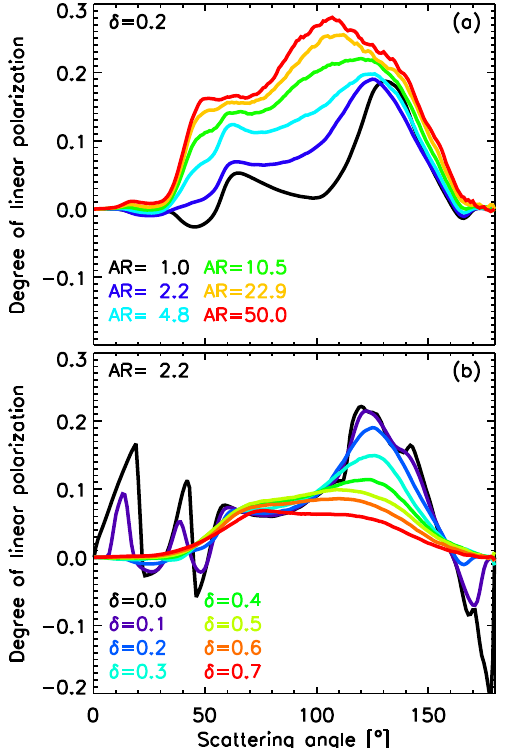
Fig. 2. Degree of linear polarization at 864nm as a function of scat- tering angle for hexagonal columns. Colors indicate DoLP functions for varying aspect ratios (AR, a ) and roughness parameters ( δ , b ).